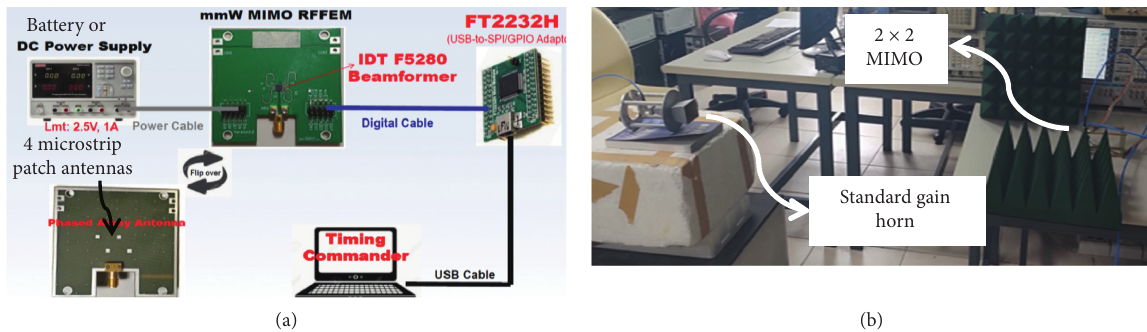
4 microstrip patch antennas